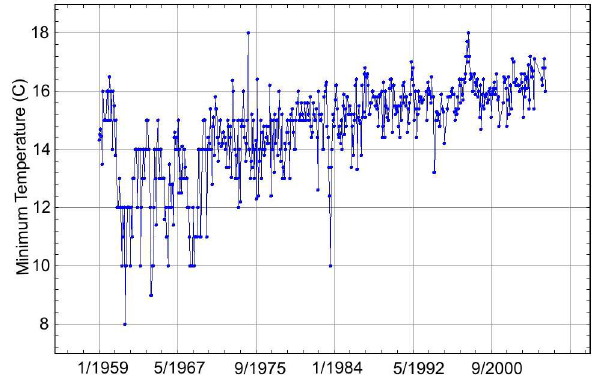
Fig. 2. Time series of average monthly minimum temperatures recorded at Pereira’s country-side airport, located around 1450ma.s.l. on the hills of the Ruiz and Santa Isabel glaciers. Table 1. Distribution in the number of time series of diverse monthly average records of Colombia during 1960–1995, exhibit- ing statistically significant increasing, decreasing or no trends, ac- cording to the studies by Mesa et al. (1997), P´erez et al. (1998), Ochoa and Poveda (2008), and Poveda (2009). Number of Increasing Decreasing No 14 Variable time series trend